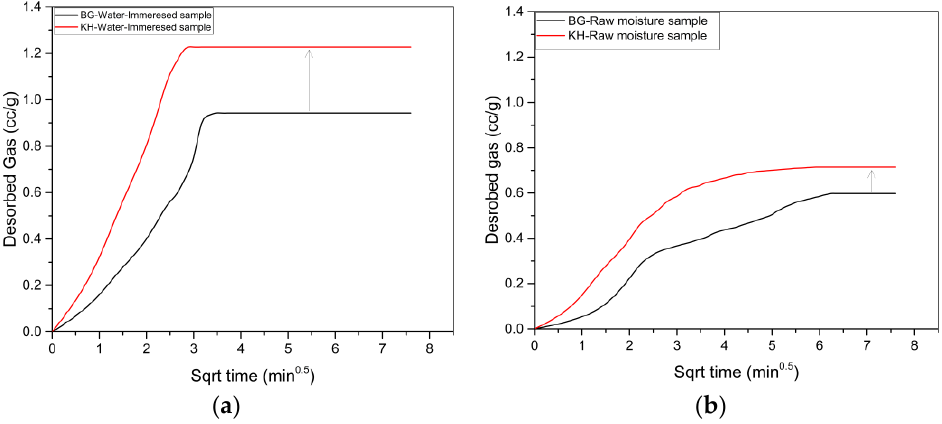
Figure 10. Desorbed gas rate and volume (cc/g) versus (min 0.5 ). ( a ) immersed case; ( b ) moist case.